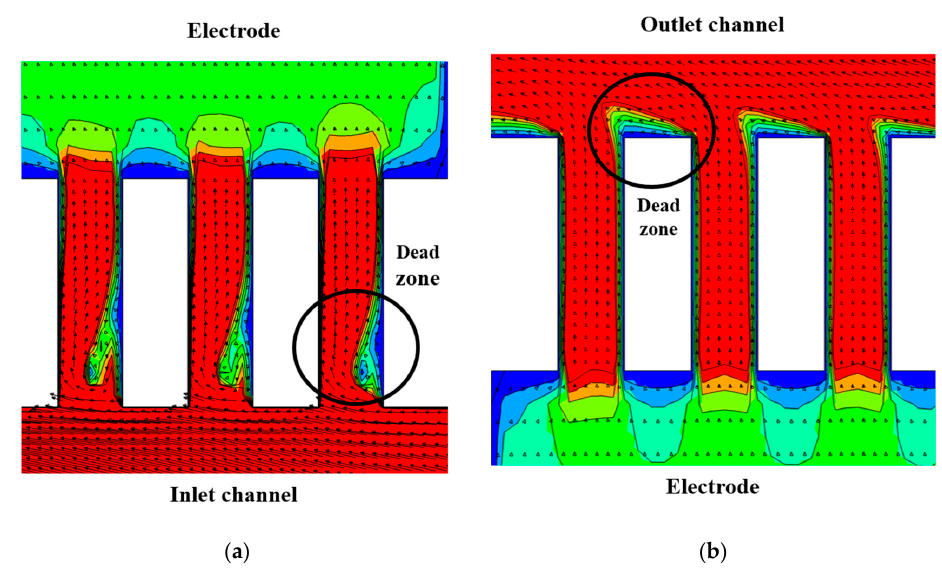
Figure 10. Velocity contours in the ( a ) inlet channel and ( b ) outlet channel of the electrode.